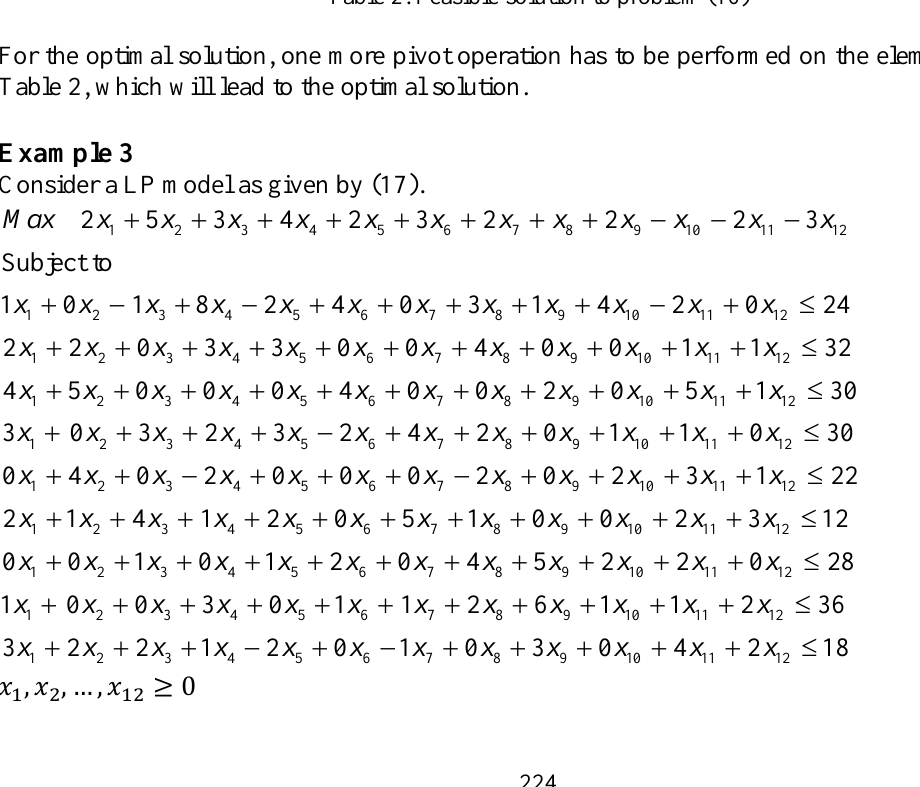
Table 2. Feasible solution to problem